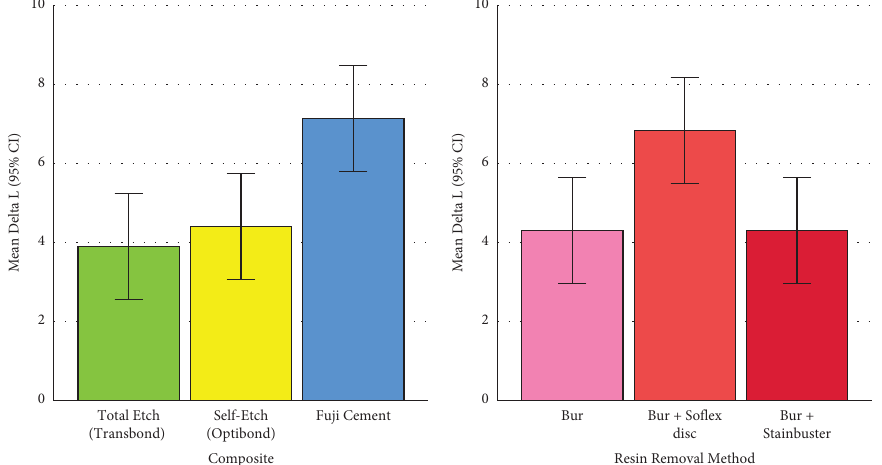
Figure 5: Means (and 95% CIs) for the Δ L parameter in 3 composites ( n � 3 × 30) and 3 adhesive removal methods ( n � 3 × 30). Te values 0–100 indicate absolutely dark (0) to absolutely bright